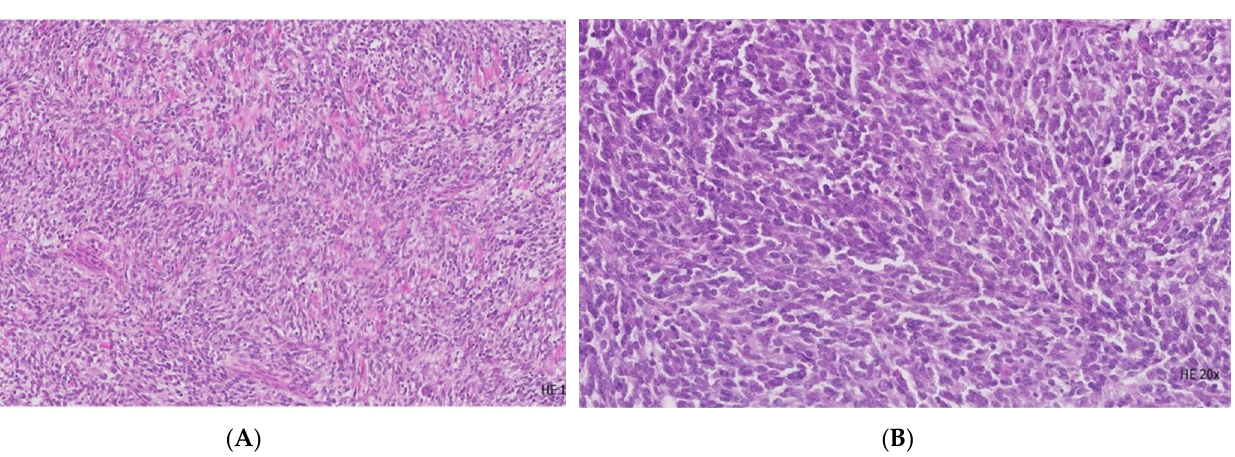
Figure 2. Histopathological evaluation. ( A ) The image shows a relatively uniform medium-sized polyhedral-epithelioid and spindle cell neoplastic proliferation with a zonal discohesive pattern, massive and focal fasciculated architecture (H&E, 10×); ( B ) The image reveals moderate cito-nuclear pleomorphism, with coarse chromatin and conspicuous nucleoli with high mitotic activity (H&E, 20×).